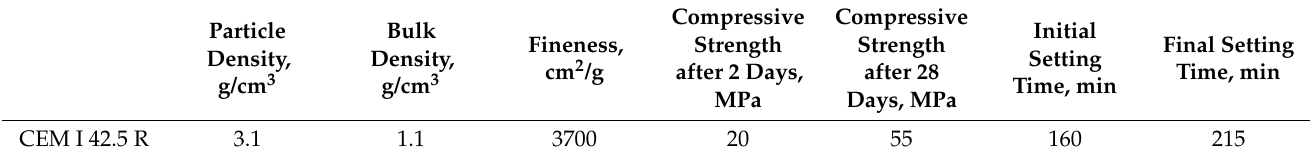
Table 2. Physical and mechanical properties of CEM I 42.5 R.